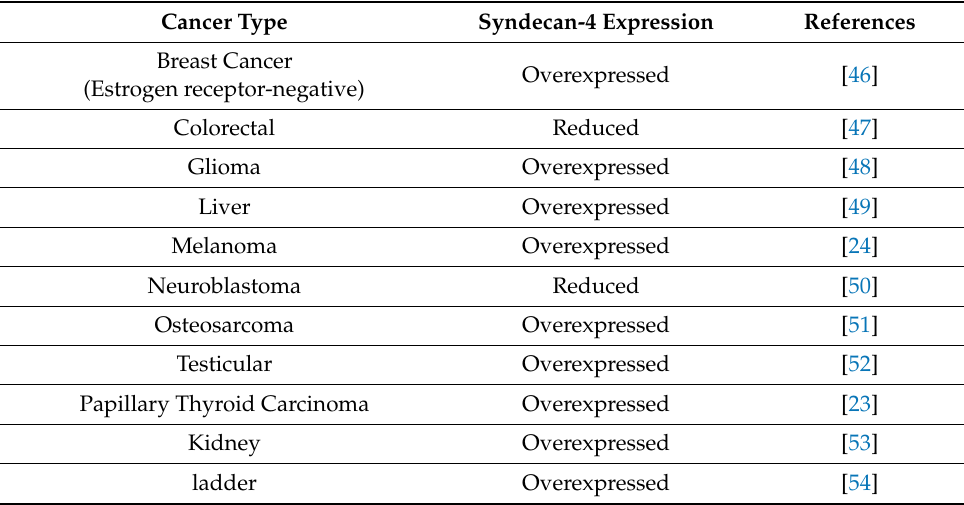
Table 1. Syndecan-4 expression in different types of